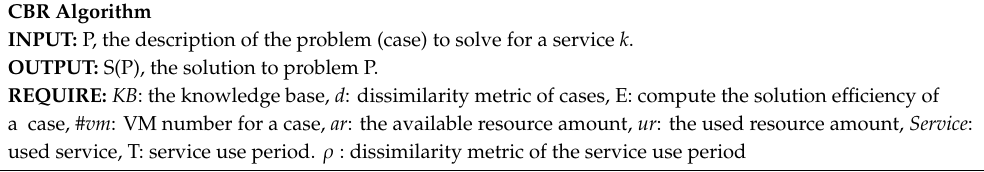
Algorithm 1. Steps performed by the case-based reasoning algorithm involved in each global manager to allocate resources demanded by a